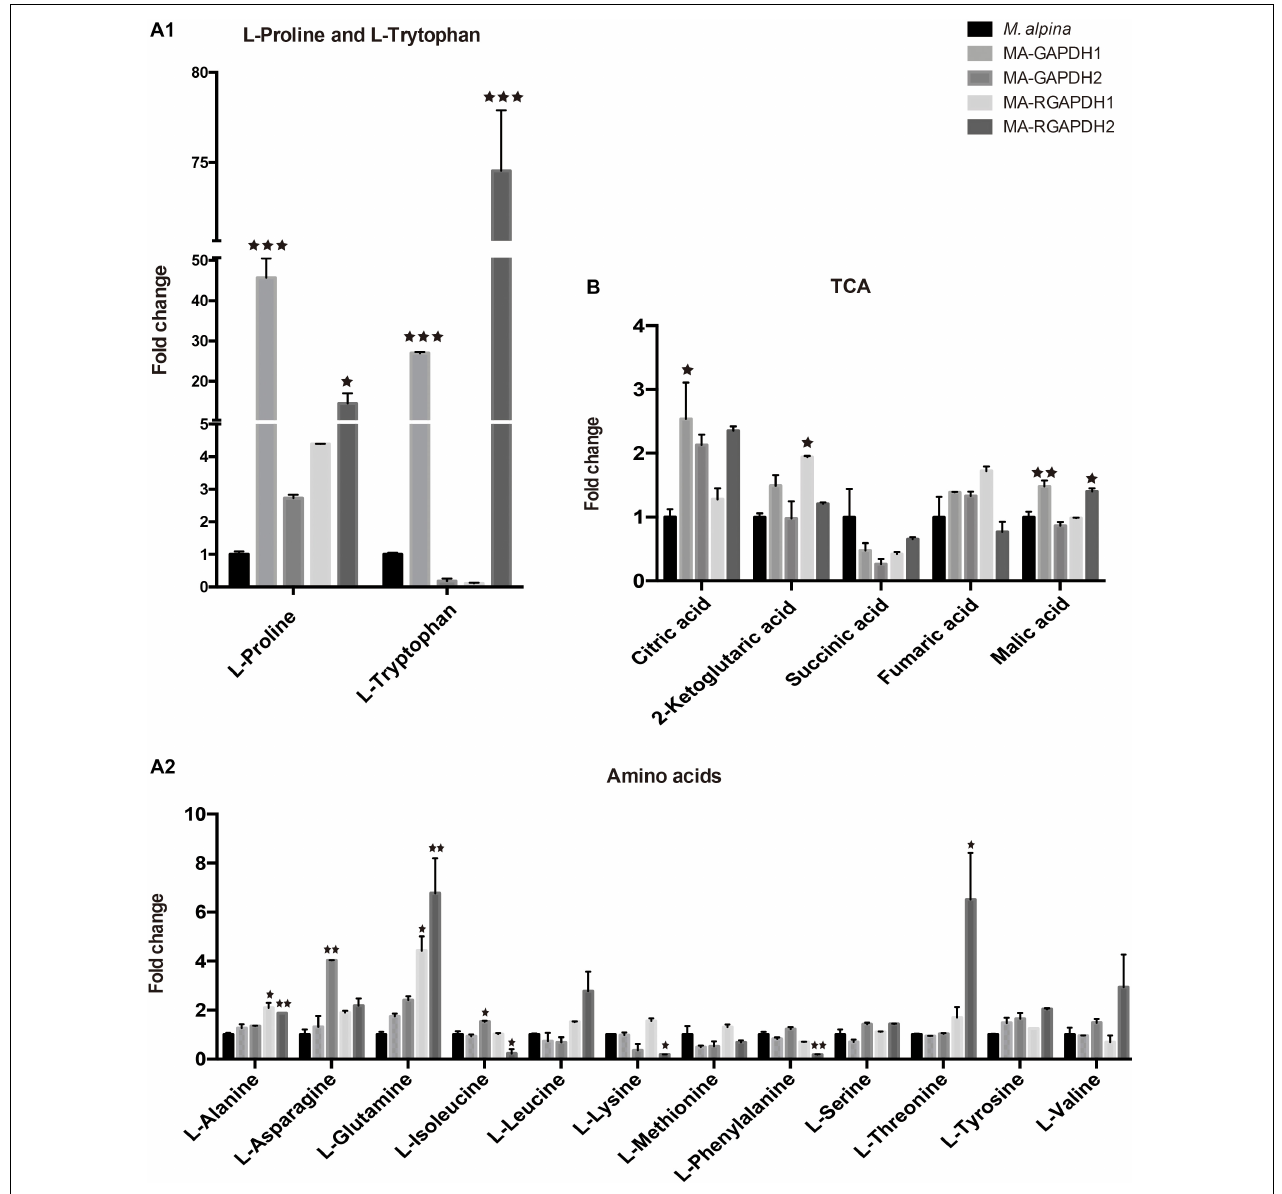
FIGURE 5 | Metabolic analysis of the amino acids and TCA (tricarboxylic acid cycle) cycle of the engineered strains (A1) proline and tryptophan analysis; (A2) other amino acids analysis; (B) TCA cycle analysis. * represents p < 0.05, ** represents p < 0.01, *** represents p < 0.001.